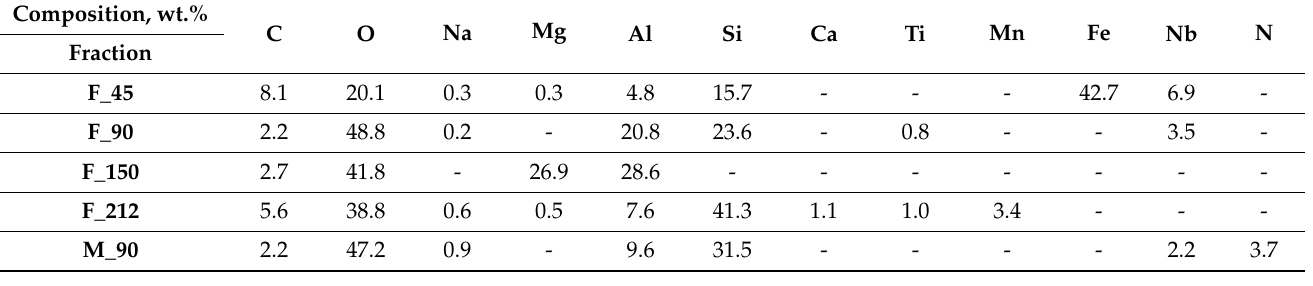
Figure 9. SEM microphotographs for CS F_90 fraction (energy: 20 keV): ( A ) SE mode, ( B ) BSE mode. Table 7. Comparison of the chemical composition of all CSs’ fractions.